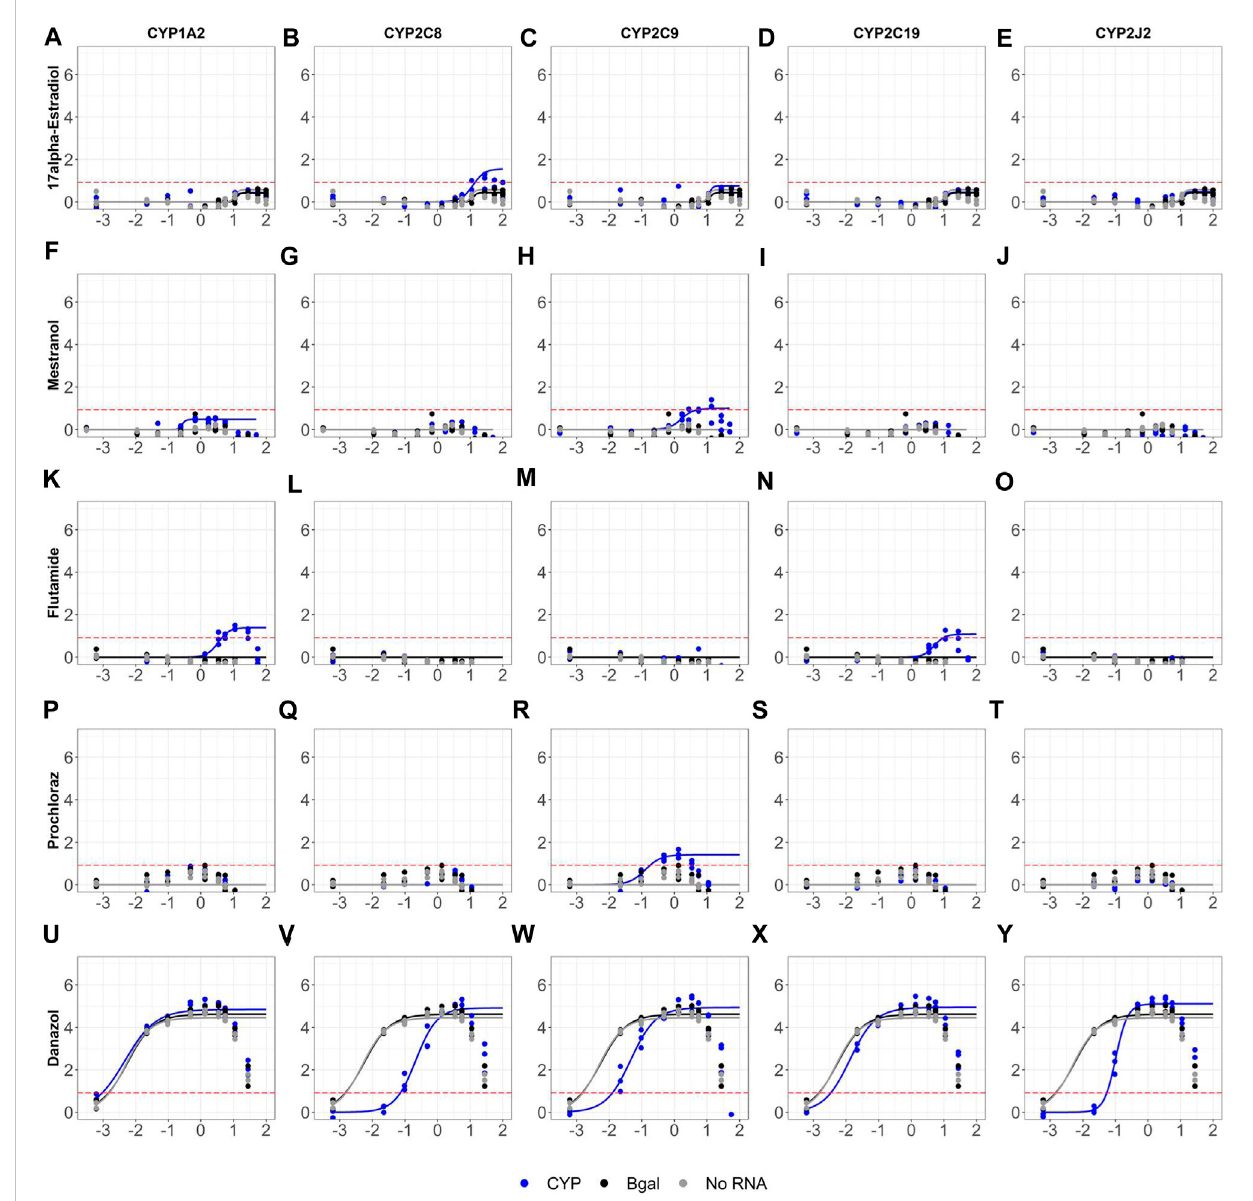
FIGURE 6 Sample retro fi tted agonist concentration-response curves for 128 evaluation chemicals. AR2 cells were transfected with mRNAs encoding beta- galactosidase (black), one of ten human CYP enzymes (blue), or no RNA (grey) for 6 hours then exposed to 128 unique chemicals at concentrations ranging from 691 pM- 99.9 μ M for 18 hours in agonist mode. Shown are the dose-response pro fi les for 17 α -Estradiol (A – E) , Mestranol (F – J) , Flutamide (K – O) , Prochloraz (P – T) and Danazol (U – Y) in cells expressing one of fi ve CYP enzymes: CYP1A2 (A,F,K,P,U) , CYP2C8 (B,G,L,Q,V) , CYP2C9 (C,H,M,R,W) , CYP2C19 (D,I,N,S,X) and CYP2J2 (E,J,O,T,Y) . Micromolar concentrations are expressed as log 10 (x-axis). Responses are expressed as fold change (log 2)over DMSO vehicle. Concentration-response curves were fi tusing tcpl_Lite. The red dotted lines represent theactivity thresholds de fi ned as 5 x bmad. Data represent individual wells from three independent experiments. The agonist response curves for all 128 chemicals tested across all ten CYP enzymes can be found in Supplementary Figure